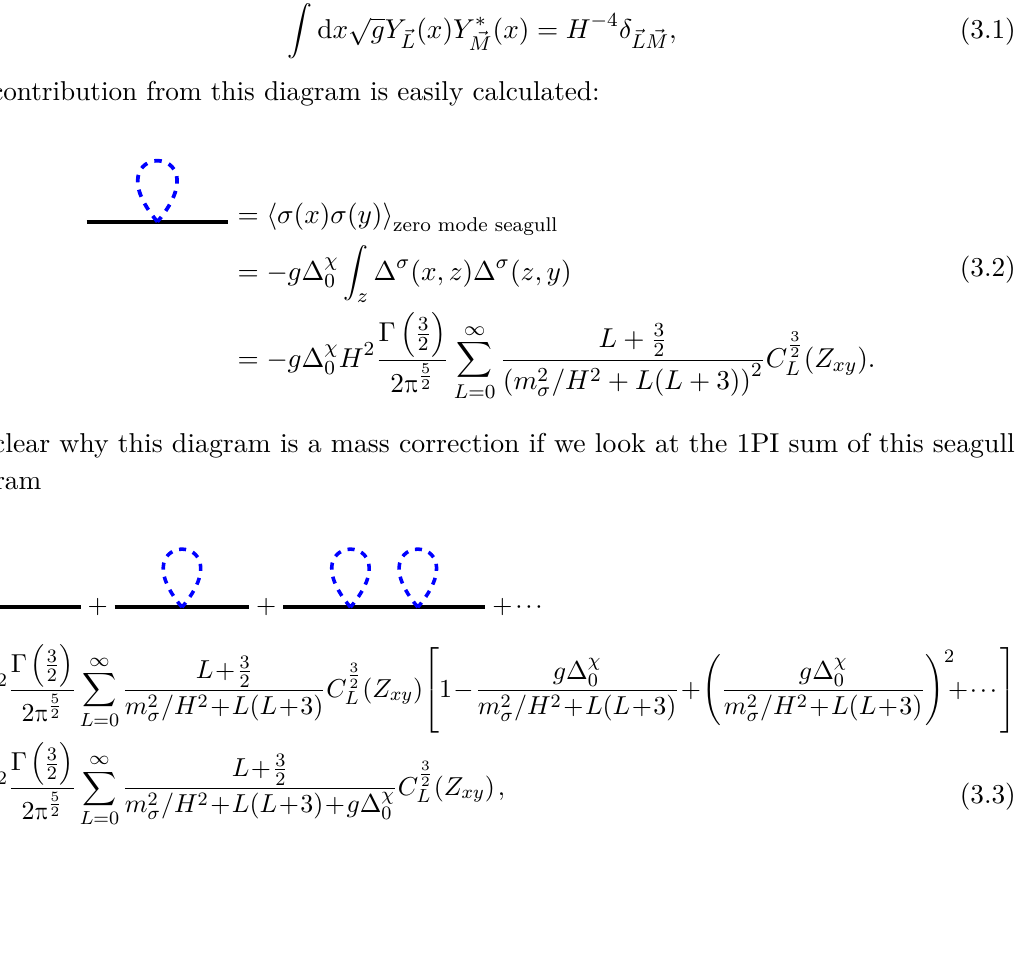
Figure 2 . Organization of Feynman diagrams in a double perturbation series in g and m 2 Black lines are σ and blue lines are χ . For the χ propagator, we distinguish the L = 0 mode (dashed line) and the L 6 = 0 modes (solid line). Diagrams with a χ zero mode are parametrically larger than the same diagram with the χ zero mode replaced by a nonzero mode. The counterterm δ (1) g is determined by calculation of the O ( g ) one-loop correction to the σ 2 χ 2 interaction, whose diagram is not shown